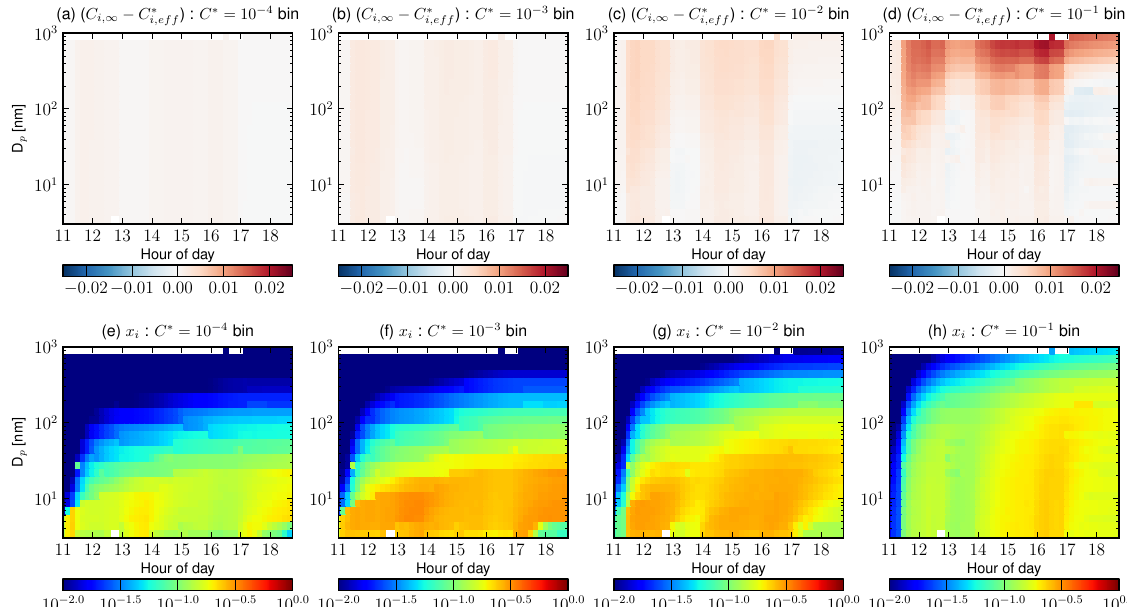
Fig. 5. Demonstration of how the equilibrium effect can inhibit ultrafine particle growth for Hyyti¨al¨a on 10 April 2007. Panels (a–d) show ) [µgm − 3 ] as a function of aerosol size and time for the C ∗ = 10 − 4 , 10 − 3 , 10 − 2 and 10 − 1 the condensational driving force ( C i, ∞ − C ∗ i, eff [µgm − 3 ] volatility bins for the simulation where pre-existing SOA has C ∗ = 10 − 5 [µgm − 3 ], freshly formed SOA has a LOGTRI volatility distribution, SOA does not readily partition into sulfate and water, the surface tension is 0Nm − 1 , and the accommodation coefficient is 1. Panels (e–h) show the mass mixing ratio ( x i , note that the volatility basis set uses mass mixing ratios rather than molar mixing ratios) as a function of aerosol size and time for the same